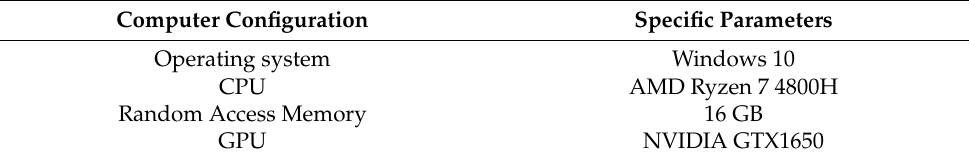
Table 1. Test System Hardware.